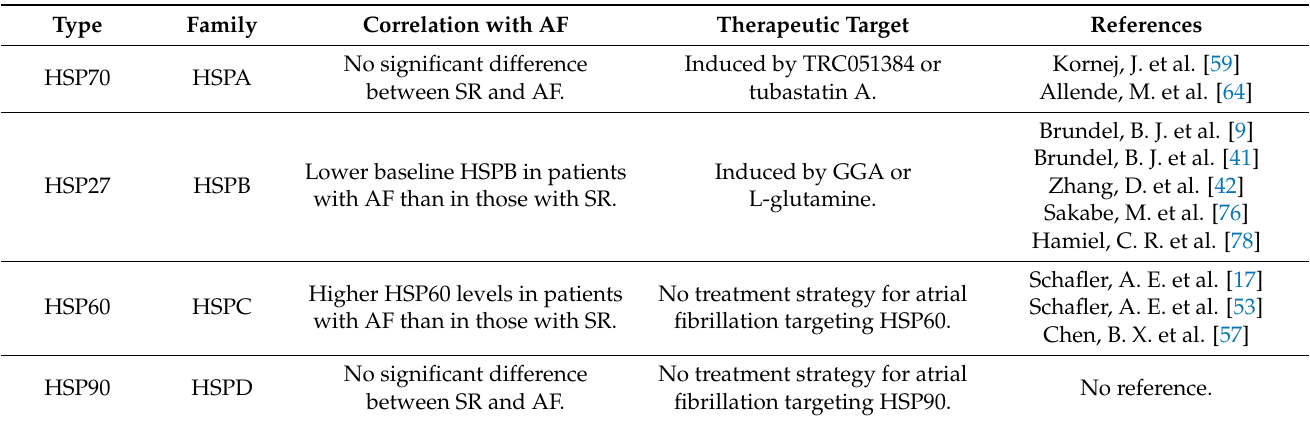
Table 1. Clinical Application of HSPs in atrial